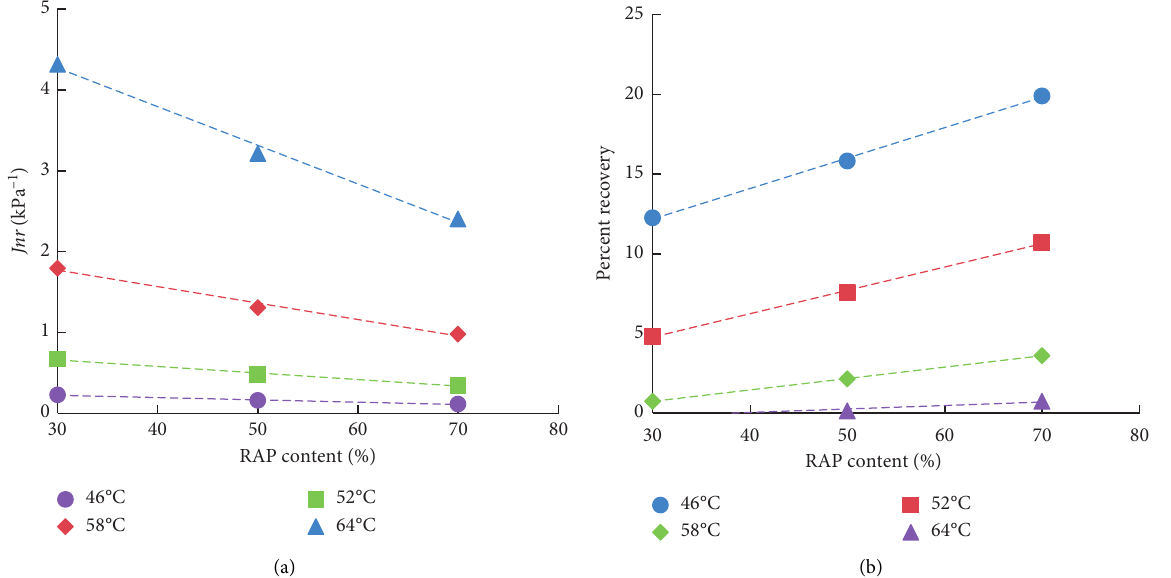
Figure 21: Relationship of aging asphalt content and MSCR parameters for RAP-M binders: (a) unrecoverable creep compliance and (b) creep percent